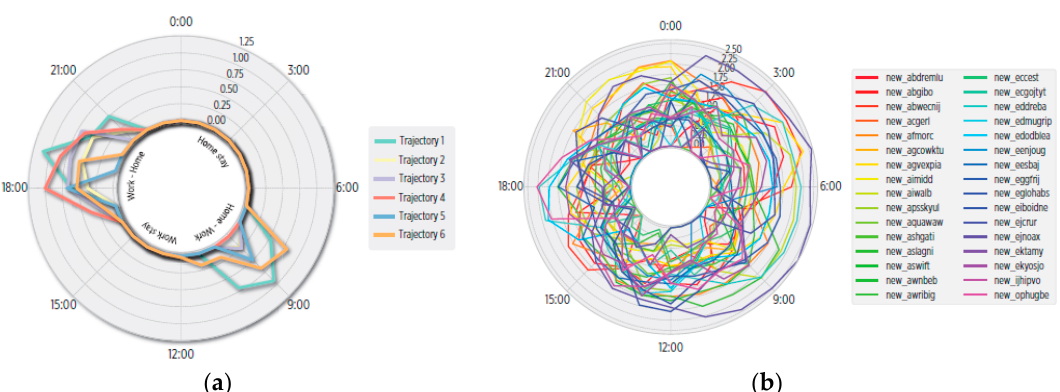
Figure 8. Hourly entropy in weekdays mobility. ( a ) For our user 1, small variations are found during 7–11 and 16–22, while in the rest of the day it is 0, as user described consistent mobility. ( b ) In the Cabspotting database, high entropy is found, highlighting the irregularity of participants’ mobility.